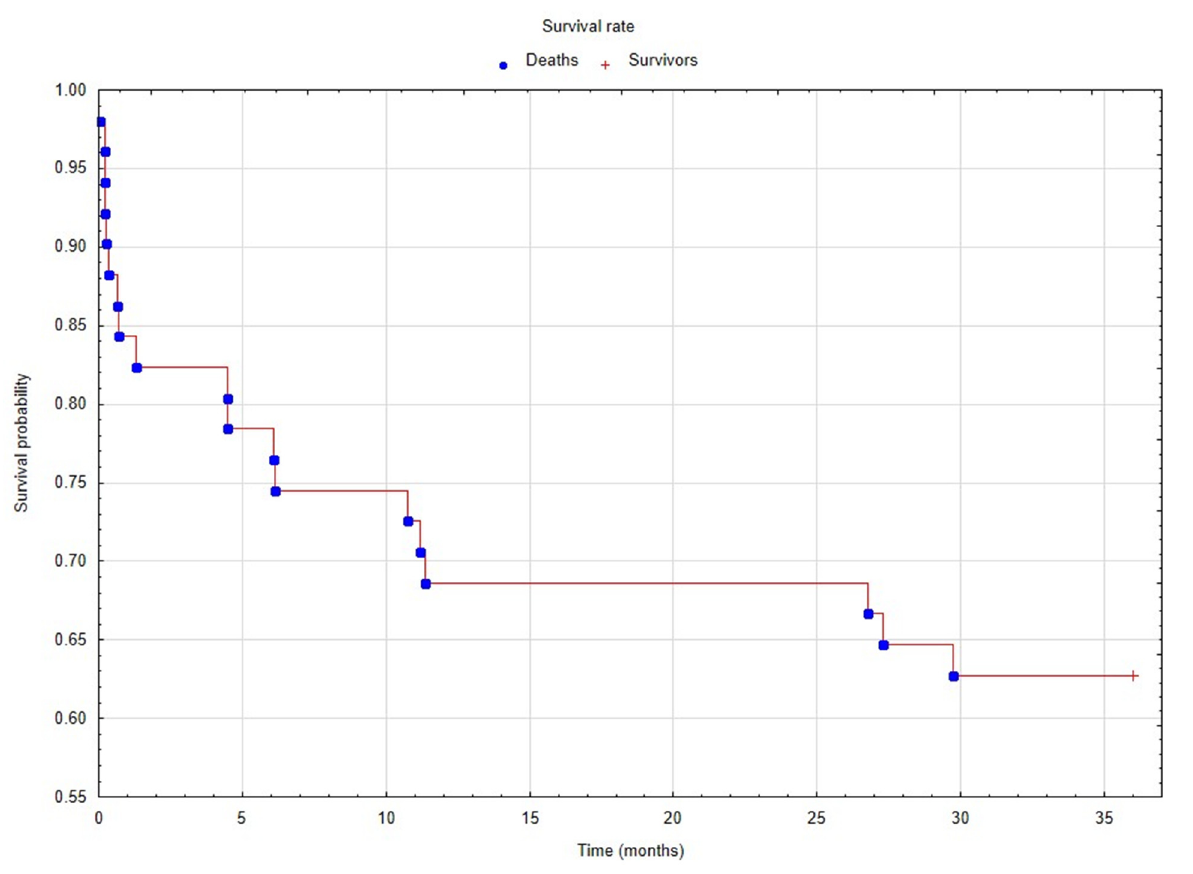
Figure 1. Survival rate in the analyzed population during 36 months of observation. The Kaplan– Meier estimates were performed to present the survival probability in patients with stroke. The estimated interquartile range for the survival was between 6.13 and 36 months, and survival rate was 62.7% (blue circle—ischemic stroke patients dead during 36-month observation time; red cross—ischemic stroke patients survived during 36-month observation time). The SUPAR 1, 3 and 7 concentration for LAO was 3.6 ± 3.0, 3.8 ± 4.9 and 4.7 ± 6.3 respectively, for lacunar 3.2 ± 1.1, 2.6 ± 1.3